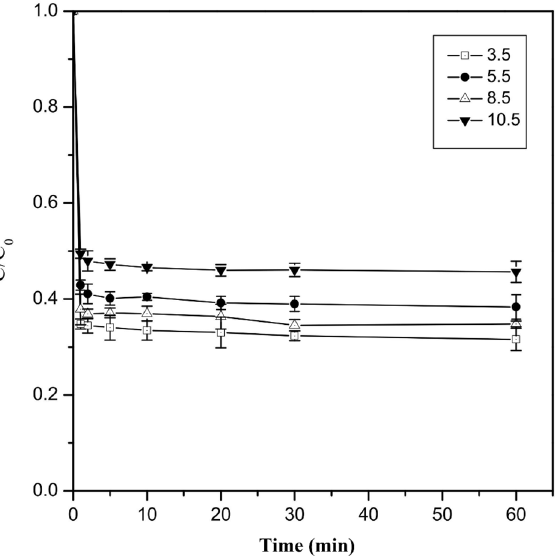
Figure 4. Effect of initial pH on Cr(VI) removal by Cu/Fe bimetallic nanoparticles. Error bars indicate the standard deviation of the mean (n =